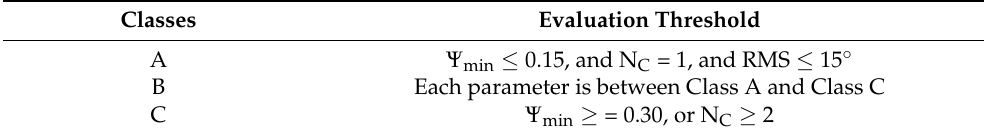
Table 3. Focal mechanism solution quality evaluation